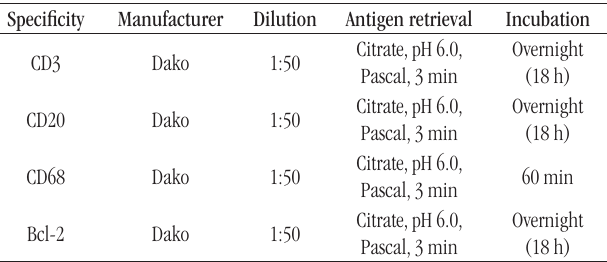
TABLE 1 – Specificity, manufacturer, dilution, antigen retrieval and incubation of antibodies used